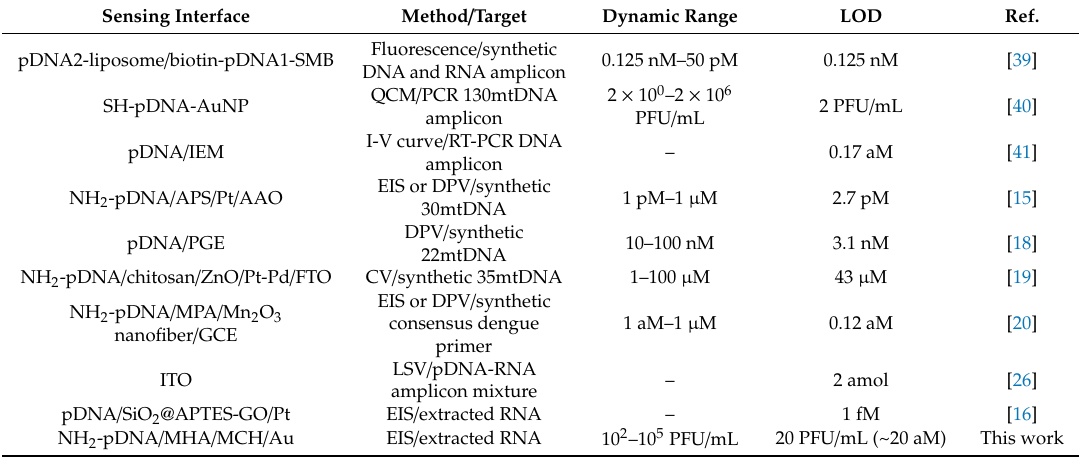
Table 3. Comparison of the Sensing Properties of Di ff erent Genosensors for the Detection of DENV. Sensing